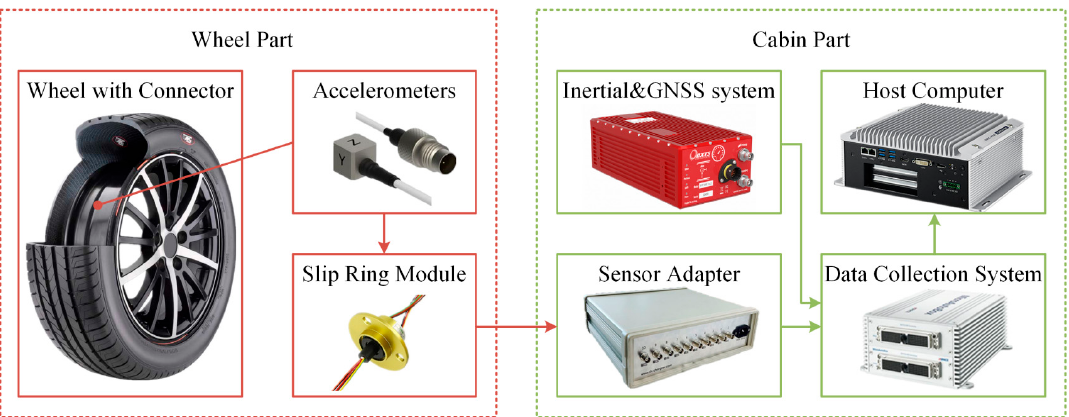
Figure 1. Overall structure of intelligent tire.